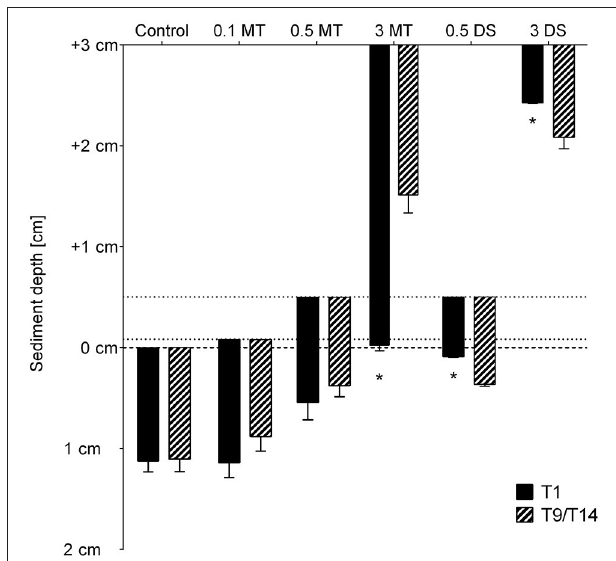
FIGURE 6 | Oxygen penetration depth (OPD) in the sediments of the different treatments one day after settlement of the substrate (T1) and at the end of the experiment (T9/T14). Error bars denote standard error and an asterisk indicates significant ( p < 0.05) differences with the control. Abbreviations: 0.1 MT = 0.1cm mine tailing addition, 0.5 MT = 0.5cm mine tailing addition, 3 MT = 3 cm mine tailing addition, 0.5 DS = 0.5cm dead sediment addition, 3 DS = 3cm dead sediment addition. The dashed line at y = 0 represents the natural sediment surface while above this layer the added substrate surface is indicated.